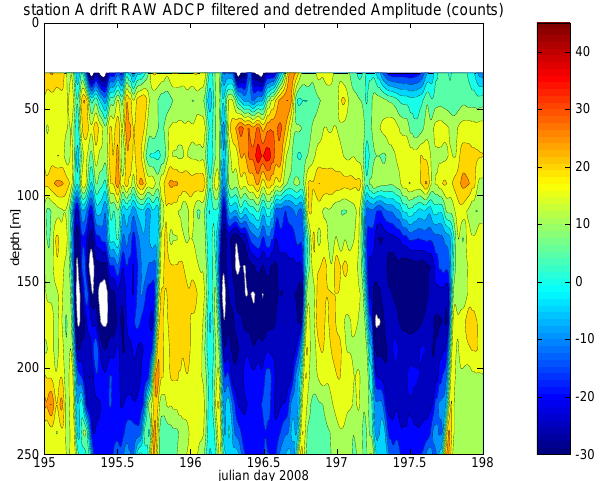
Fig. 7. Time series of vertical profiles of ADCP (78khz) estimates of raw acoustic backscattering signal filtered (30min window) and detrended to remove water absorption. The minimum bin depth was about